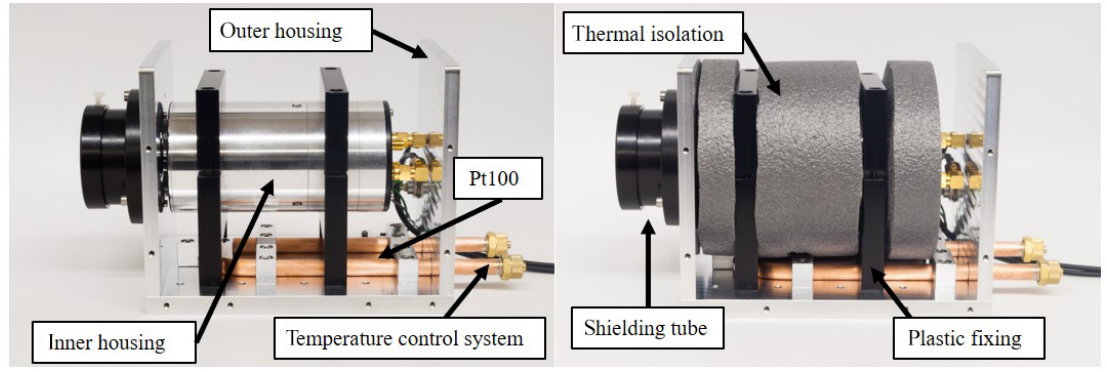
Figure 8. Inner and outer housing (not pictured: outer sheet cover).